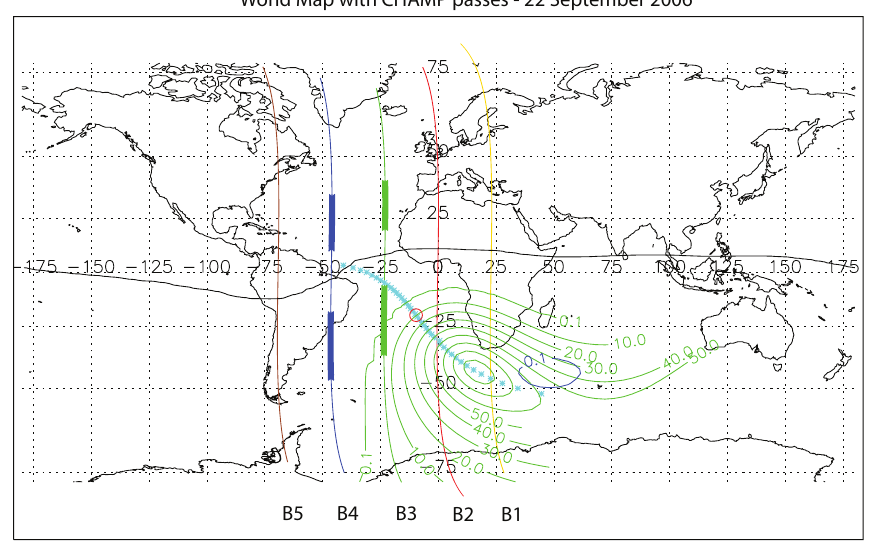
Fig. 6. World map projection showing the path of the eclipse (cyan), the CHAMP passes considered and the latitude of the magnetic equator (solid line). The bold parts of passes B3 and B4 indicate the location of the FAC regions. Contours indicate the expected shadow distribution at the time of the dip equator crossings of passes B3 and B4 (green and blue, respectively). The red circle indicates the closest approach for the B2